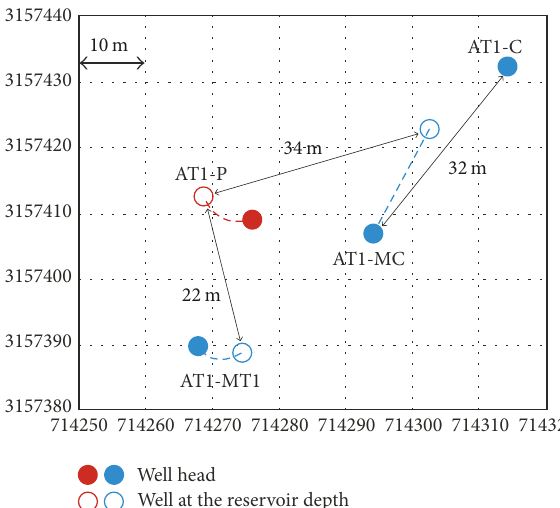
Figure 1: Horizontal section showing the locations of production, monitoring, and sampling wells at the AT1 site